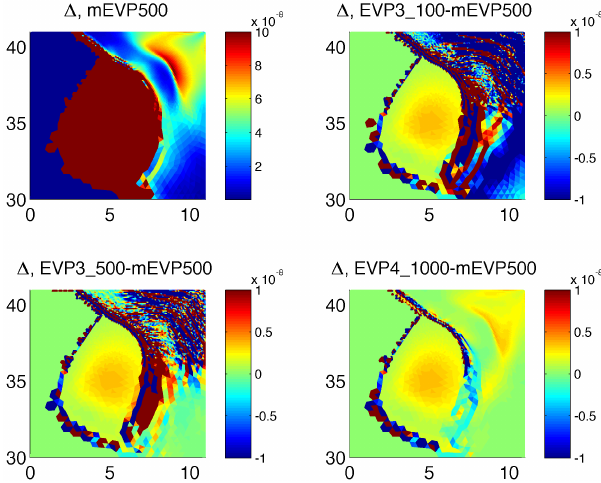
Figure 8. Ice mean thickness h ice (m) after 1 month of simula- tions in mEVP500 (top left) and differences between it and EVP solutions: EVP3_100-mEVP500 (top right), EVP3_500-mEVP500 (bottom left) and EVP4_1000p-mEVP500 (bottom right). The last EVP solution (bottom right), obtained with modified equations for stresses, shows the results almost identical to mEVP (see the text for details).